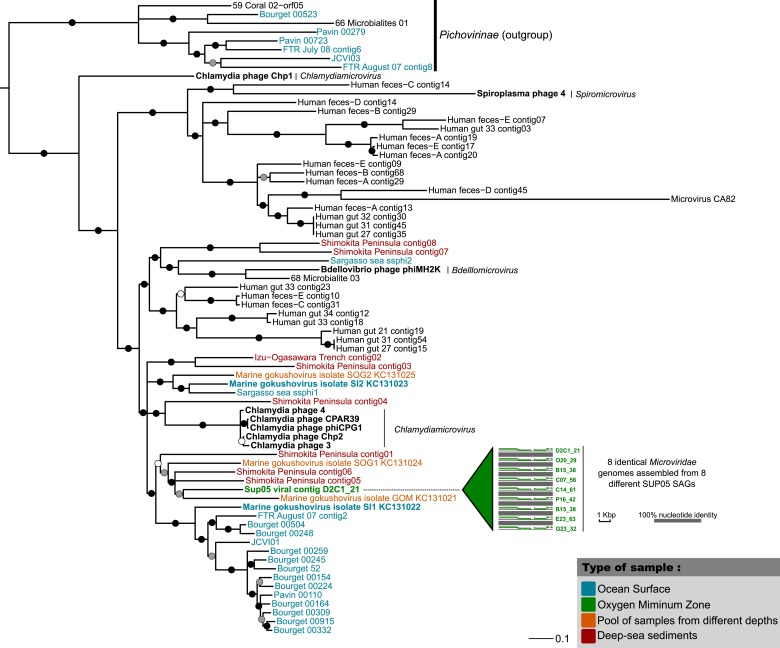
Phylogenetic tree for the SUP05 Microviridae (major capsid protein).Tree was computed with PhyML (maximum-likelihood tree, LG model, gamma parameter estimated with CAT approximation), and SH-like supports are indicated for each branch. All branches with support lower than 0.50 were collapsed. The tree is focused around the Gokushovirinae subfamily and includes the Pichovirinae subfamily as an outgroup. Aquatic Gokushovirinae are colored according to their type of sample, and Saanich Inlet sequences are highlighted in bold. Cultivated Gokushovirinae are noted in black and highlighted in bold, with the associated genus associated in italic. All the other sequences are non-cultivated and currently affiliated to ‘Unclassified Gokushovirinae’.